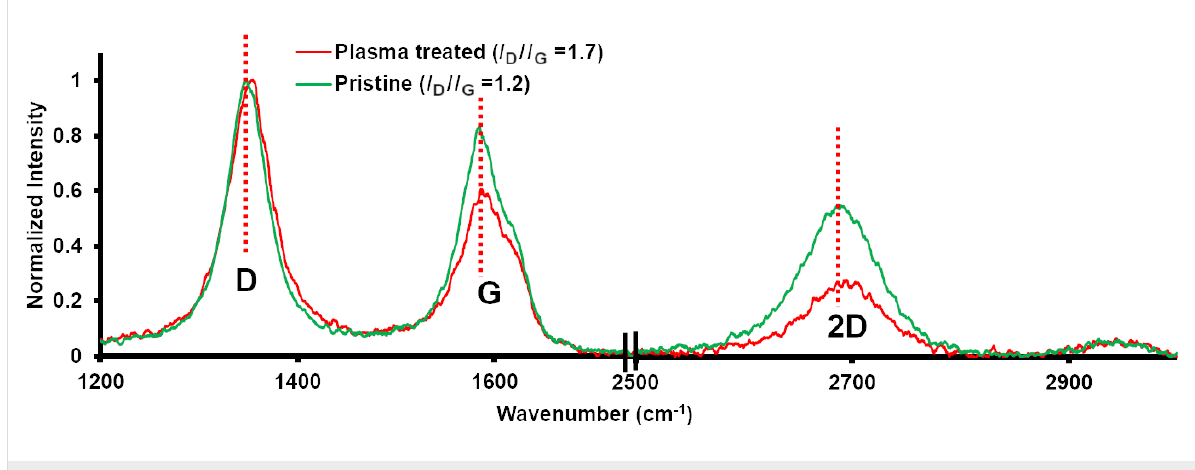
Figure 1: Raman spectra obtained for pristine as well as N 2 -plasma-treated sample.